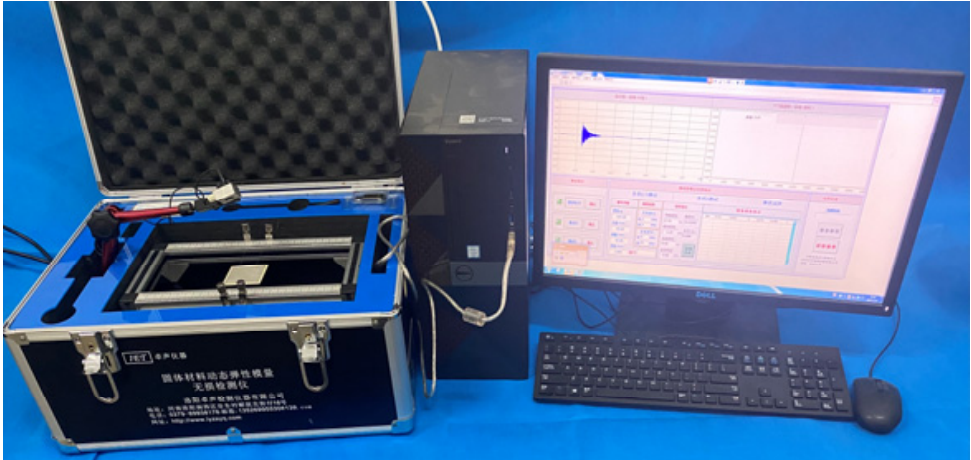
Figure 4. A non-destructive detector (ET-01). (whether have clearer one)